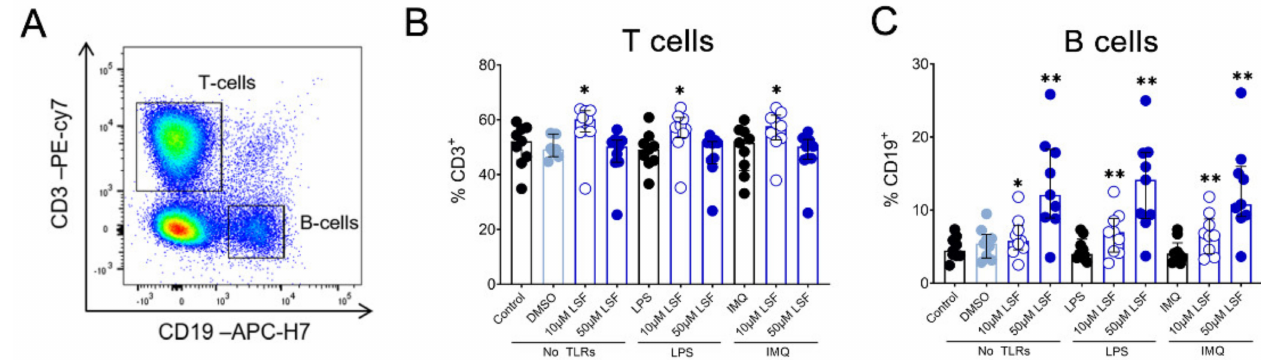
Figure 2. The effect of LSF on adaptive immune cell populations. Flow cytometric gating strategy ( A ) and the proportion of T cells ( B ) and B cells ( C ) ( n = 9) displayed as a proportion of total lymphocyte populations. The median ± IQR range is presented. The medium control was used as the control group for comparisons with the TLR-stimulated groups; the DMSO control was used as the vehicle control for comparison with the LSF treatments. * p < 0.05, ** p < 0.01 compared to the respective untreated control, with statistical analysis performed using a non-parametric Wilcoxon signed-rank test.